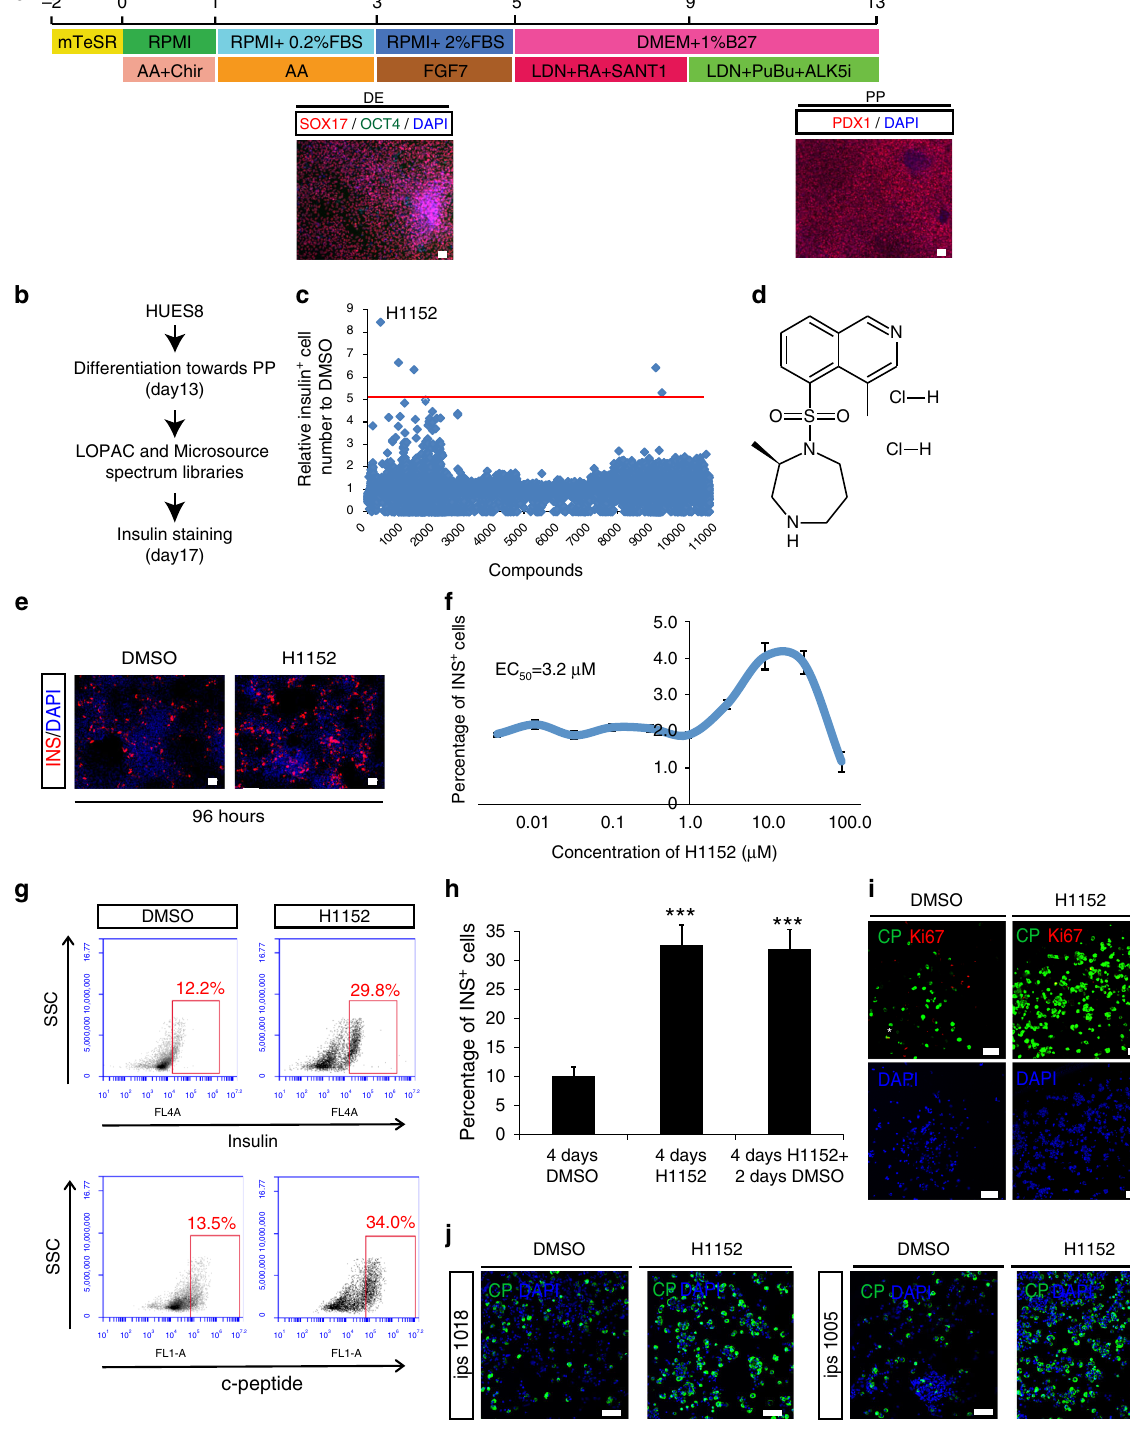
Fig. 1 High content screening to identify H1152 that promotes the generation of INS + cells. a Scheme of the directed differentiation protocol and representative images of hESC derived de fi nitive endoderm (DE) and pancreatic progenitors (PP). Scale bar = 50 µ m. b Scheme of the chemical screen. c Primary screening result. d Chemical structure of H1152. e Representative images from primary screening. Red : insulin/INS, blue : DAPI. Scale bar = 50 μ m. f Dose response curve for effects of H1152 on percentage of INS + cells. g Intracellular FCM to detect the expression of insulin ( upper graphs) and c- peptide ( lower graphs) of DMSO or H1152-treated cells. h The increase of INS + cells does not depend on the continued presence of H1152. N = 3 independent biological replicates. p -values were calculated by unpaired two-tailed Student ’ s t-test. *** p < 0.001. Error bar is SEM. i Immuno fl uorescent imaging of DMSO or H1152 treated cells stained with antibodies against insulin and Ki67. Scale bar = 50 µ m. j Immuno fl uorescent imaging of DMSO or H1152 treated cells for c-peptide expression in 2 different iPSC lines. Scale bar = 50 µ m. AA Activin A; RA Retinoic